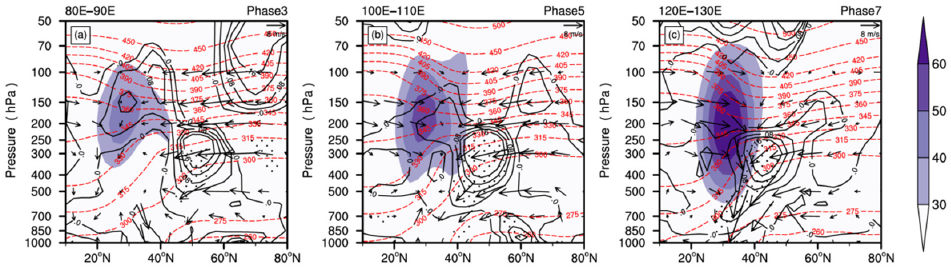
Figure 7. Latitude–pressure profiles of zonally averaged westerly jet (shaded, unit: m/s), potential temperature (red dashed line, unit: K), wind (vectors, unit: m/s), and 10–20 d low frequency isobaric PV (contour, unit: PVU, dotted area encloses regions of larger than 0.01 significance) at phases 3, 5 and 7 along latitudes 80–90° E ( a ), 100–110° E ( b ), and 120–130° E ( c ), respectively.